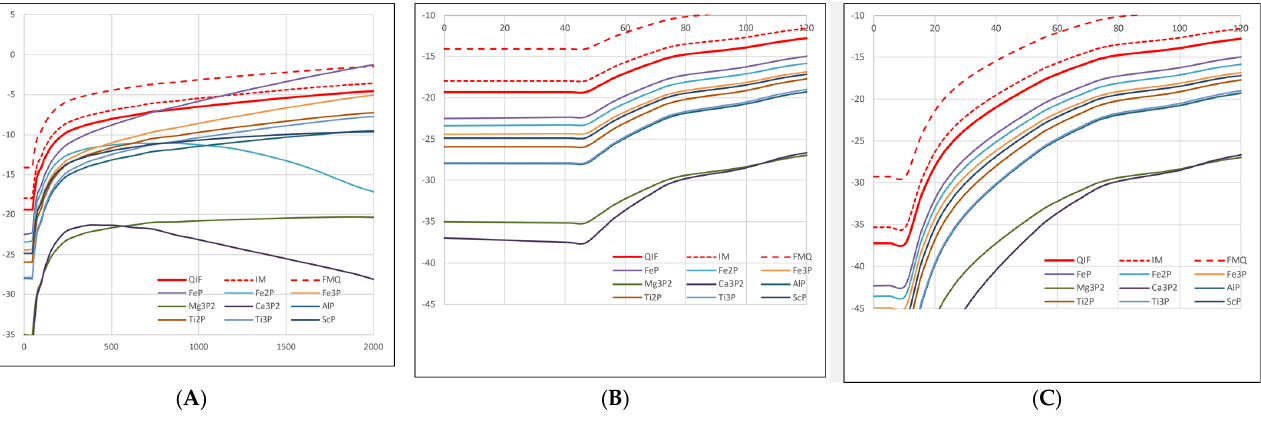
Figure 3. Thermodynamic analysis shows that phosphide is strongly disfavored over phosphate at lithospheric depths. X -axes: depth in kilometers. Y -axes: oxygen fugacity (log 10 [f(O 2 )]), calculated from free energy of reaction forming metal phosphide and oxygen from metal phosphate. ( A ) Full analysis to depth of 2000 km, for melt temperature of 1100 K. ( B ) Detail on the top 200 km, for melt temperature of 1100 K. ( C ) Top 200 km for melt temperature of 660 K. Iron phosphides are shown to be stable over phosphates at depths of 850 km or 1600 km if the mantle is QIF/IM or FMQ redox state respectively, but no phosphide is preferred over phosphate above 800 km in depth.